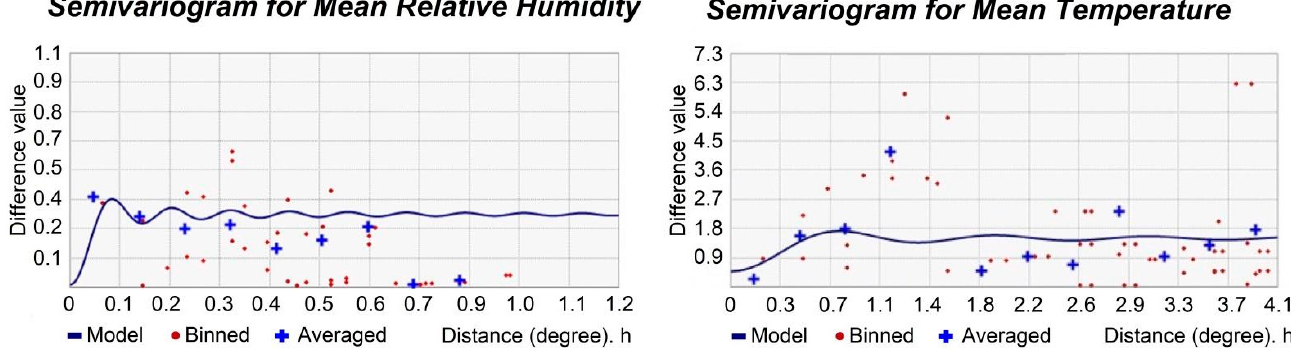
Figure 5. Transformed semivariograms for mean temperature and mean relative humidity .